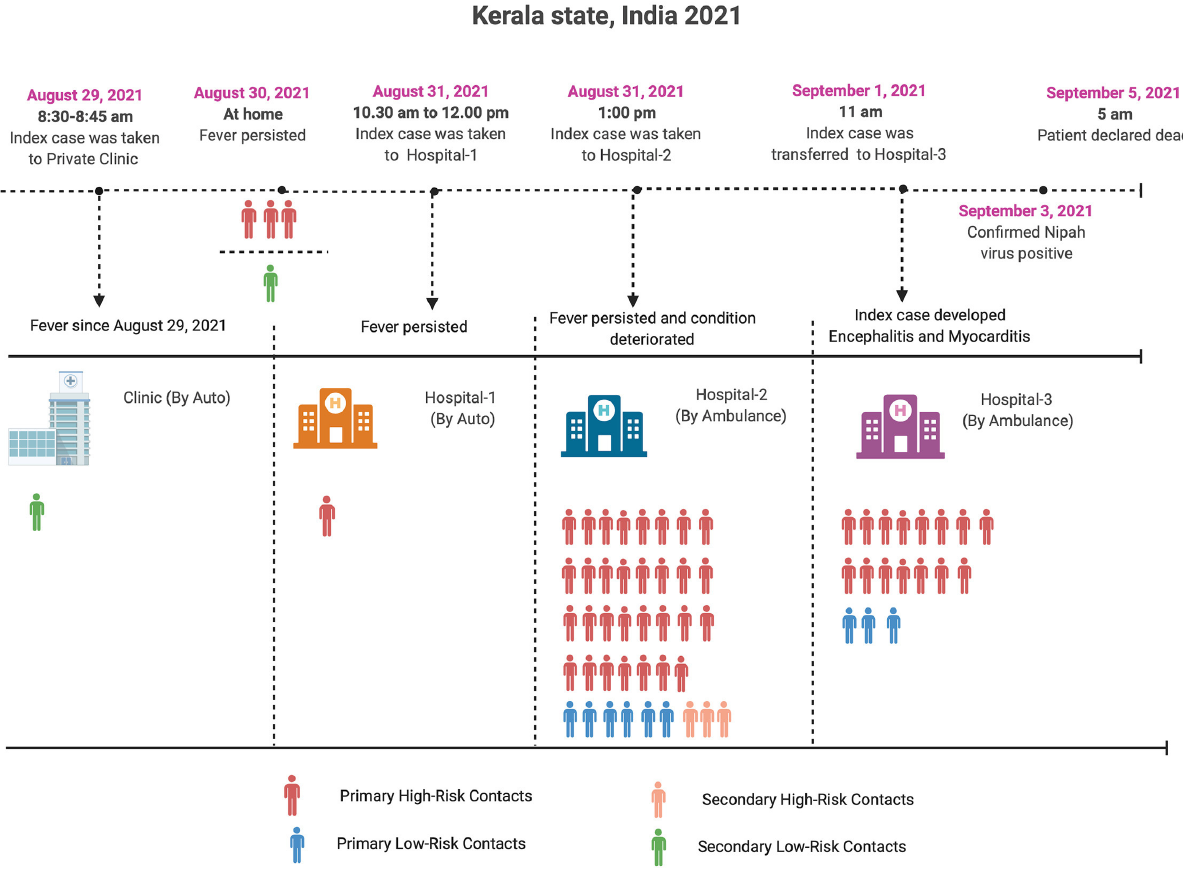
Frontiers in Public Health |